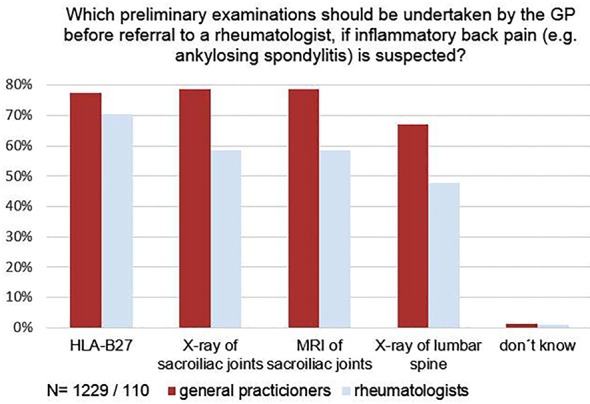
Opinion on necessity of examinations to be acquired by the GP before referral to a rheumatologist, if inflammatory back pain is suspected.The difference between GPs and rheumatologists was statistically significant for x-ray of sacroiliac joints and x-ray of lumbar spine (both p<0.001). * p value based on Fisher's exact test